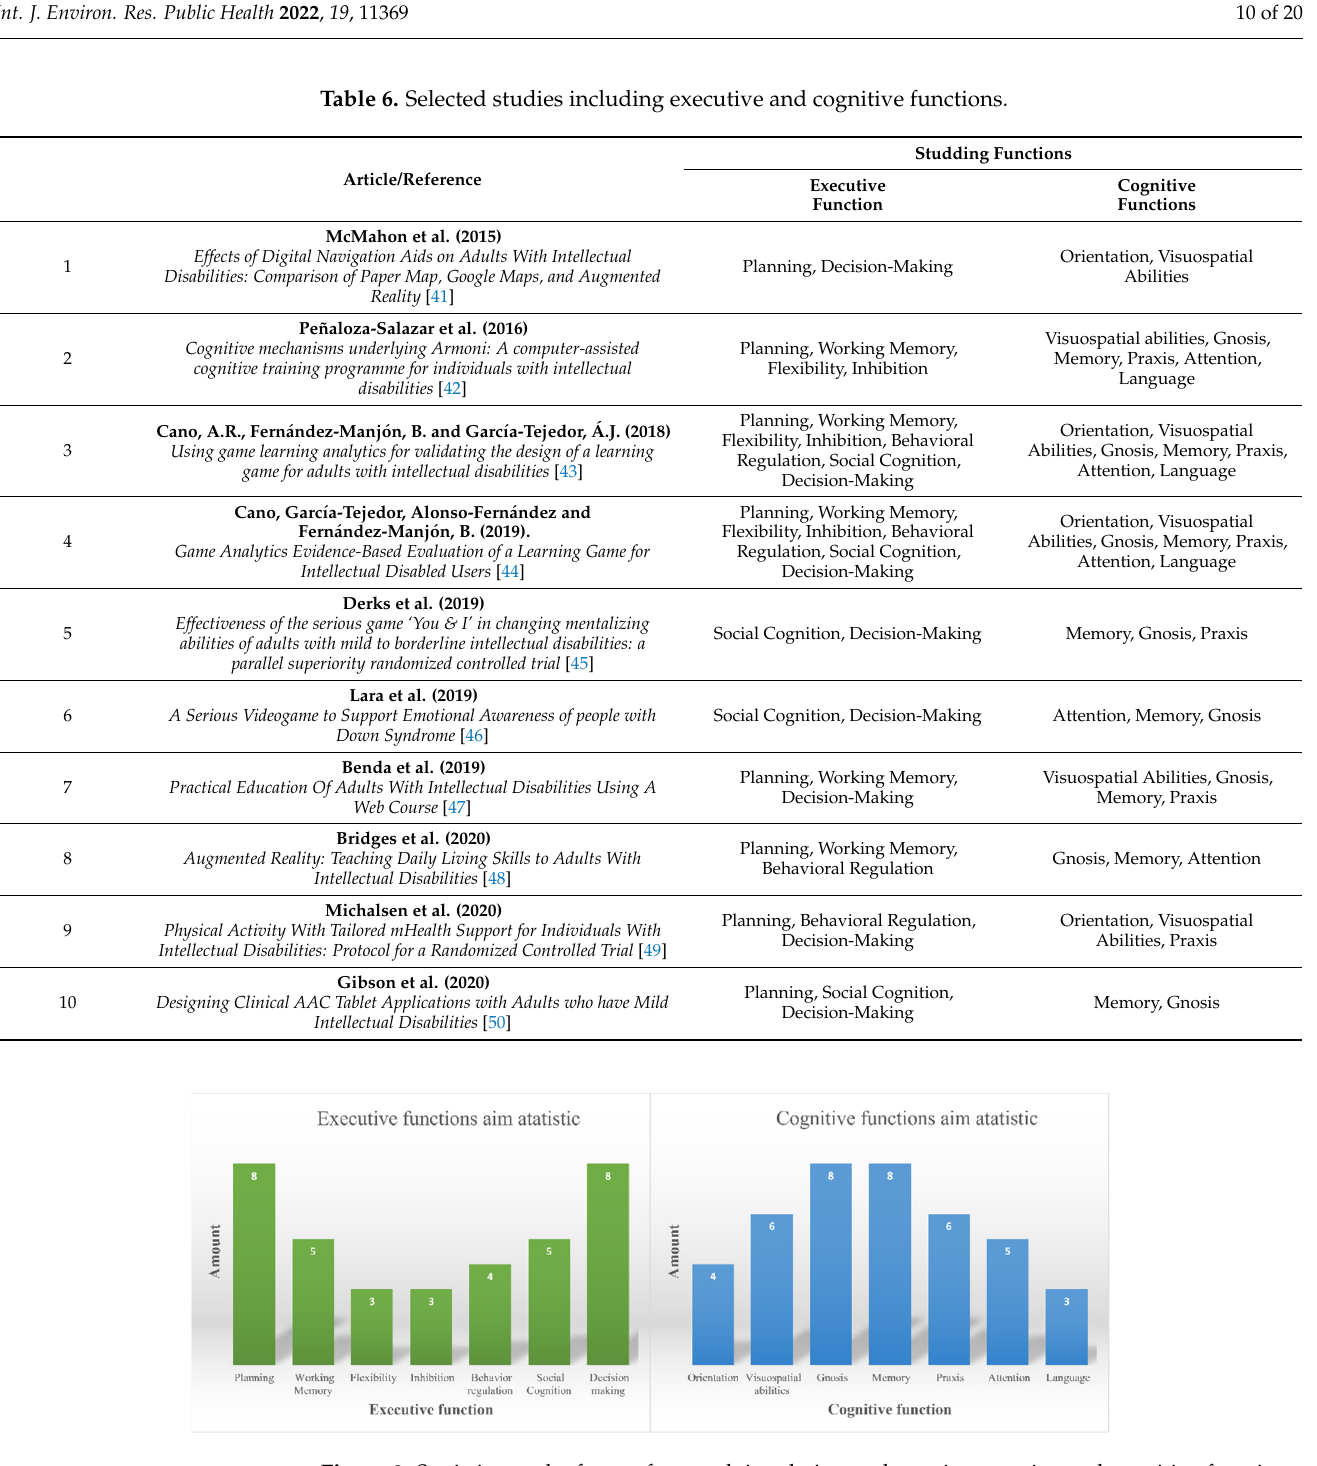
Table 6. Selected studies including executive and cognitive functions.